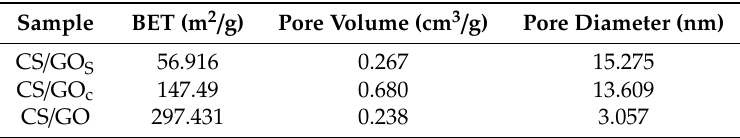
Figure 2. ( A ) SEM photographs of aerogels: ( a 1 , a 2 ) CS/GOc, ( b 1 , b 2 ) CS/GO S , and ( c 1 , c 2 ) CS/GO, ( B ) adsorption performance of CS/GO aerogels prepared by three experimental methods on methyl orange solution. Table 1. Hole structure analysis of the aerogels.